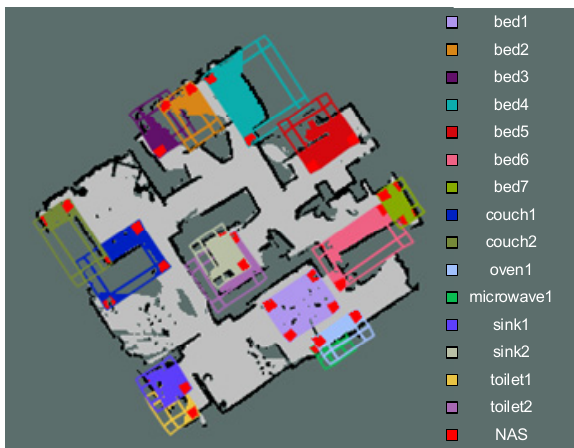
Figure 13. Object semantic gird map.